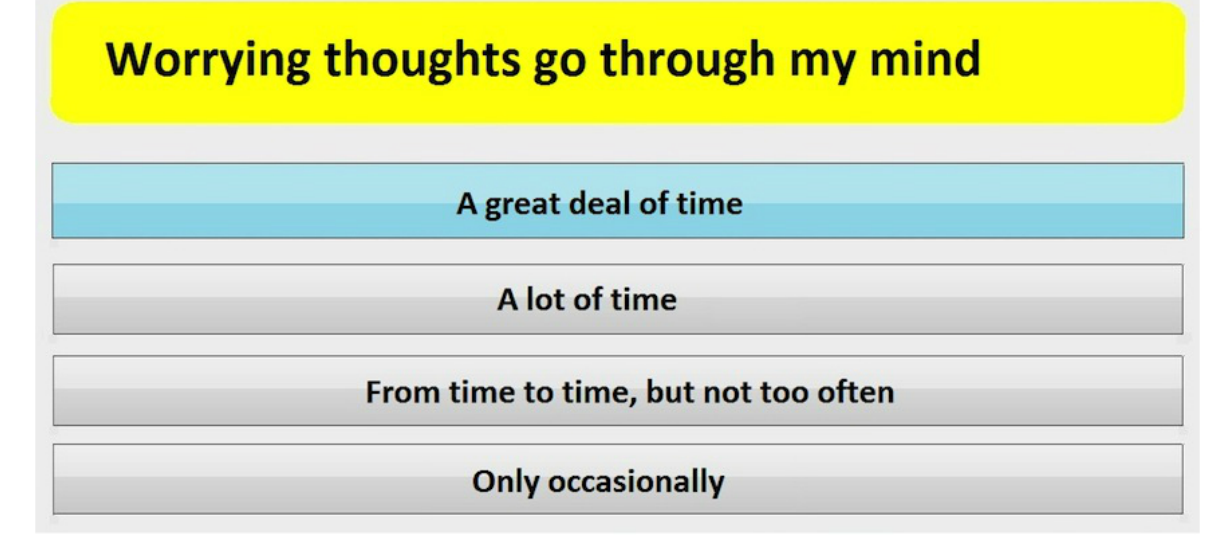
Figure 1. Screenshot of one of the questions of the Hospital Anxiety and Depression Scale as presented to the patient on the touchscreen (translated from Dutch to